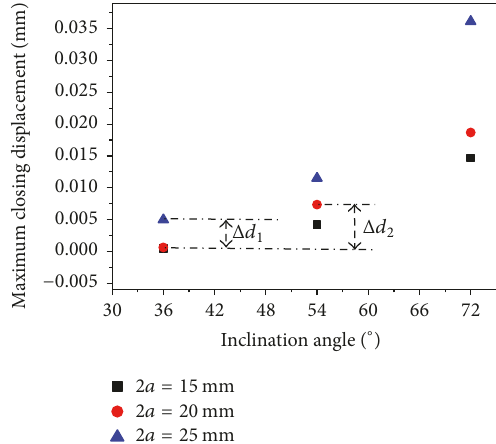
Figure 10: Maximum closing displacement for the specimens with preexisting cracks oriented at 36 ∘ , 54 ∘ , and 72 ∘